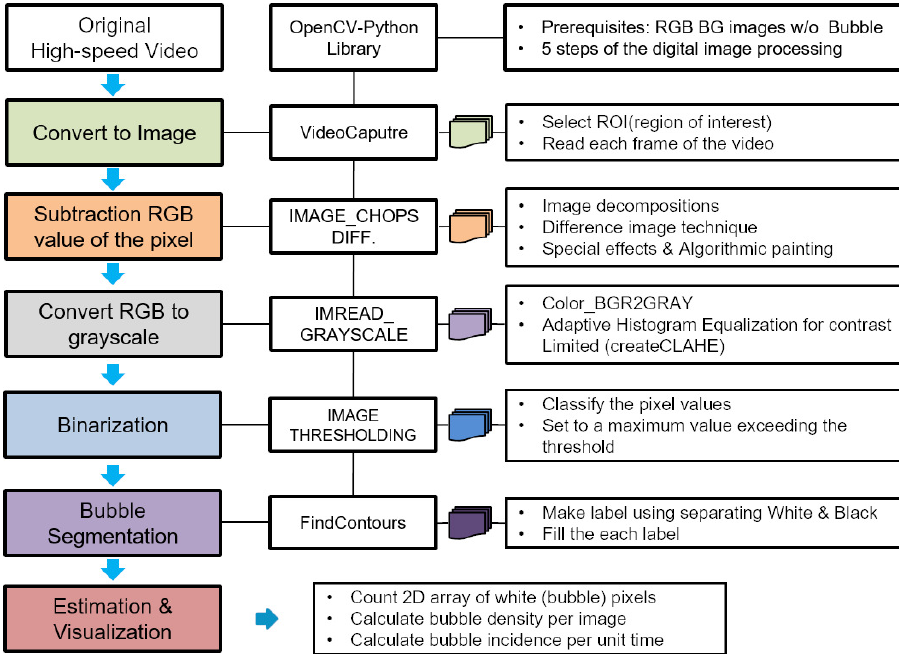
Figure 6. The algorithm utilized for evaluating spatial density, SD , in the observation window for any generic case.